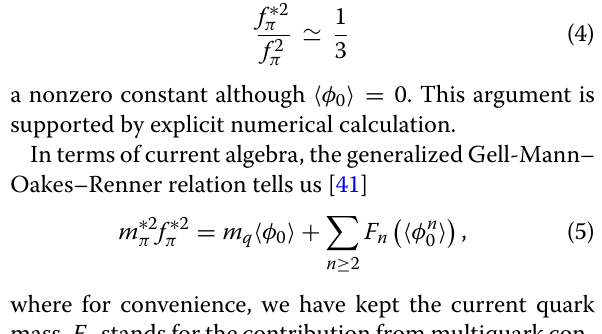
One finds that, after a critical density n 1 / 2 (or equally,